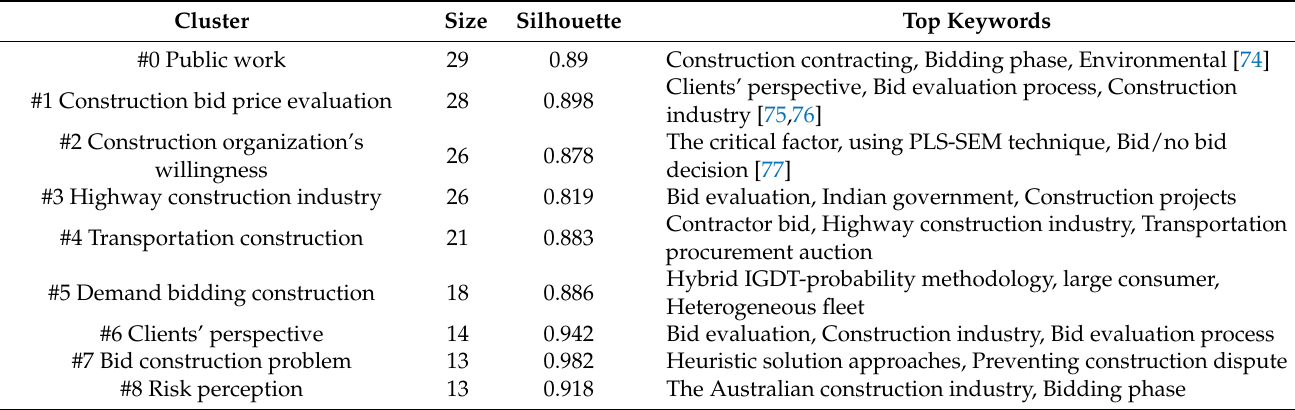
Table 3. List of clusters in construction bidding research.